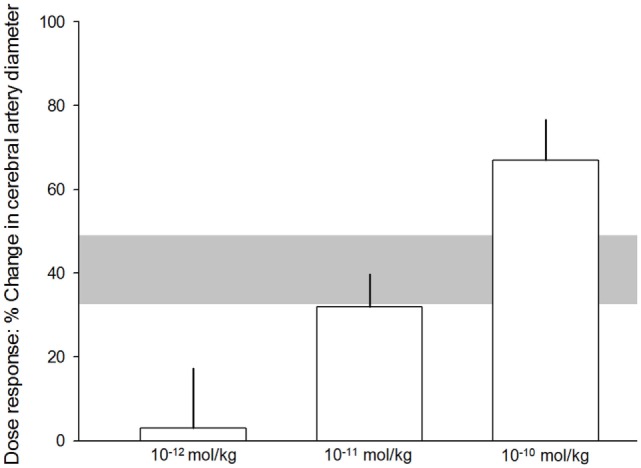
Dose–response relationship. 10−12 mol/kg of alpha calcitonin gene-related peptide (αCGRP), 3.1 ± 14.2%. 10−11 mol/kg αCGRP, 32 ± 7.8%. 10−10 mol/kg αCGRP, 67 ± 9.7%. The error bars represent SE while the shaded gray area represents the SE of the grouped (all experiments with single doses) estimate. Differences were statistically significant (p < 0.05).